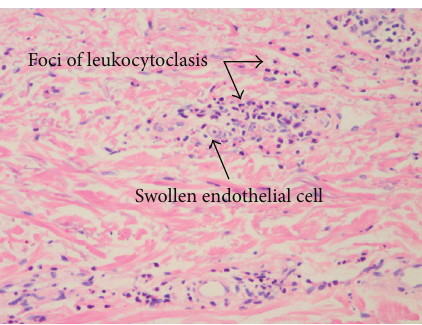
Figure 2: Punch biopsy skin. Punch biopsy of the skin shows swollen endothelial cells and foci of leukocytoclasis consistent with early leukocytoclastic